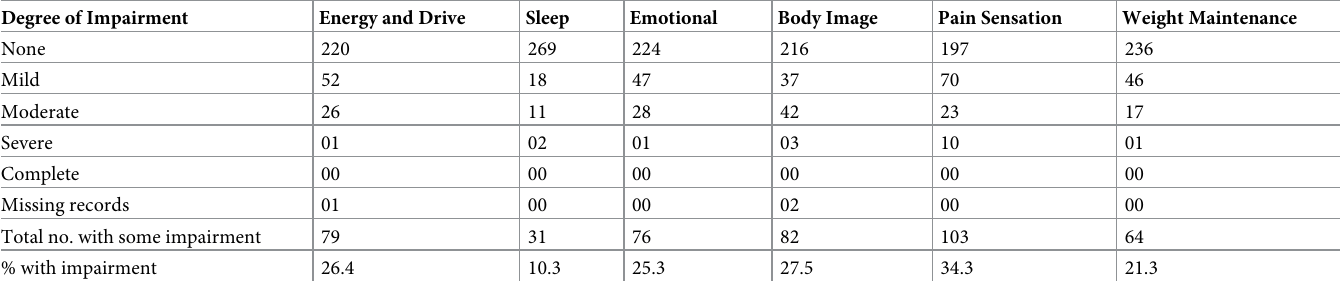
Table 3. Impairments in body